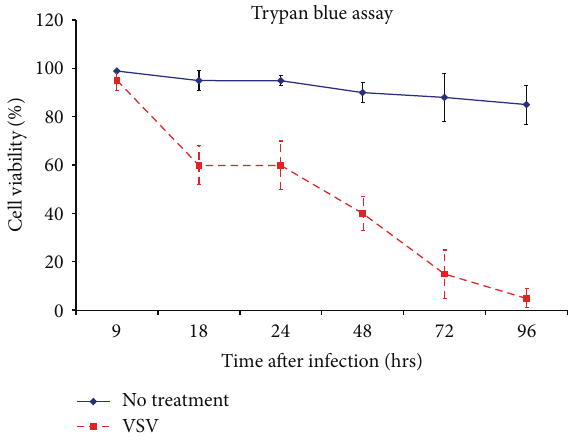
Figure 4: EWS cell death is assessed quantitatively by trypan blue assay. EWS cells were inoculated with VSV Δ M51 at MOI 0.1. Viability of tumor cells at 96h after infection is less than